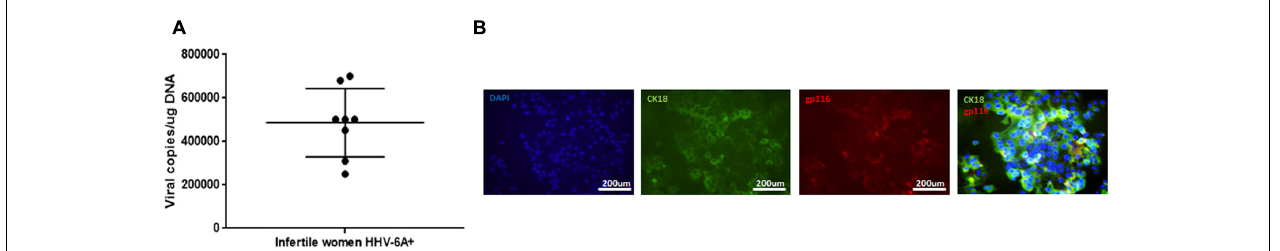
FIGURE 1 | HHV-6A infection of endometrial epithelial cells. (A) HHV-6 DNA was searched by real time qPCR specific for U94 gene in endometrial biopsies. Results are expressed in viral copies/ug DNA and represent the mean copy number ± SD referred to duplicates of 2 independent assays. Infertile women: primary idiopathic infertile women; (B) Endometrial epithelial cells were characterized by immunofluorescence for cytokeratin18 (CK18, epithelial marker) and gp116 (late viral protein) expression. Images were taken in fluorescence (Nikon Eclipse TE2000S) equipped with a digital camera. Original magnification 20 × .